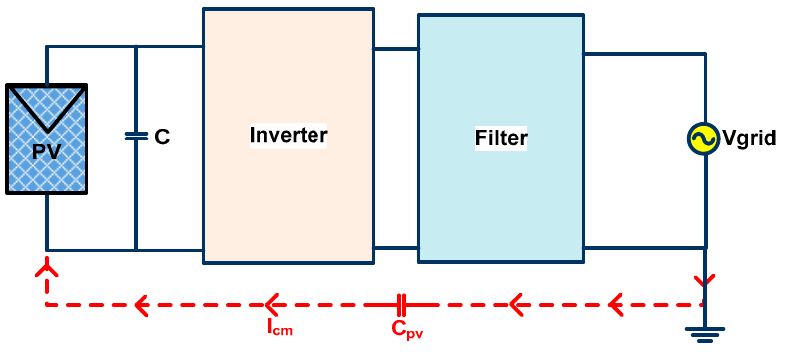
Figure 1. Leakage current path in a transformerless inverter.